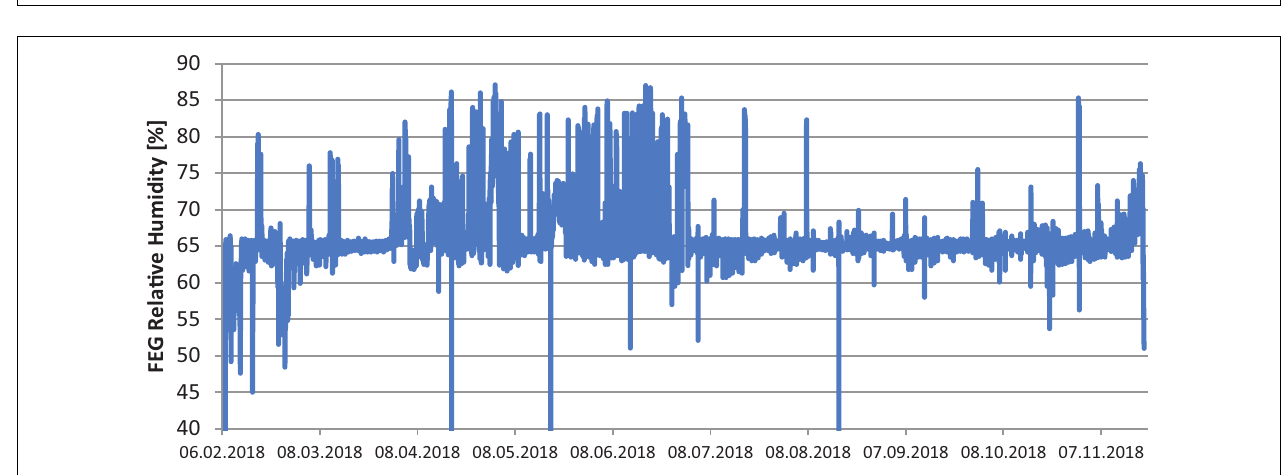
FIGURE 4 | FEG air temperature during the experimental phase (one data point per minute).